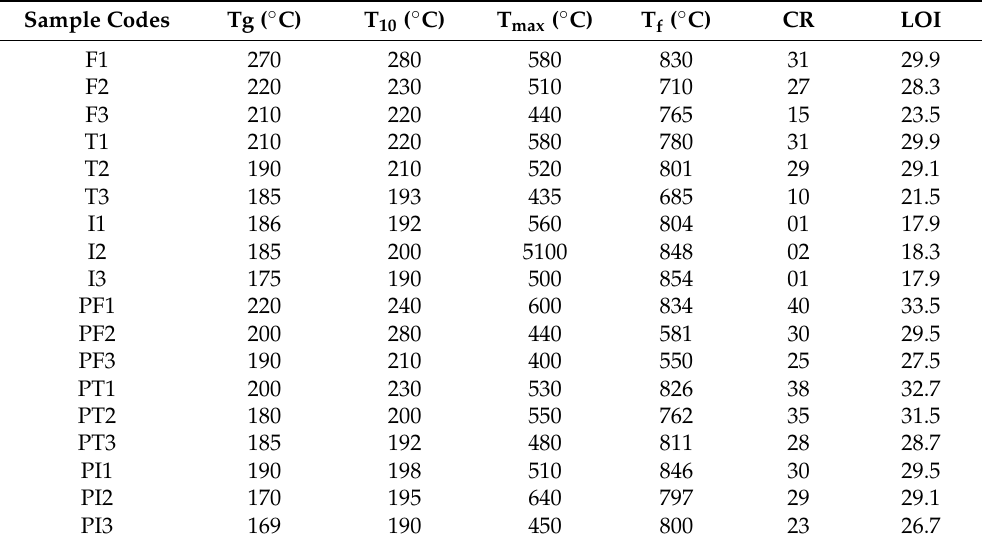
Table 2. Thermal properties of the ferrocene-based terpolyamides, block copolymers, and their corresponding organic